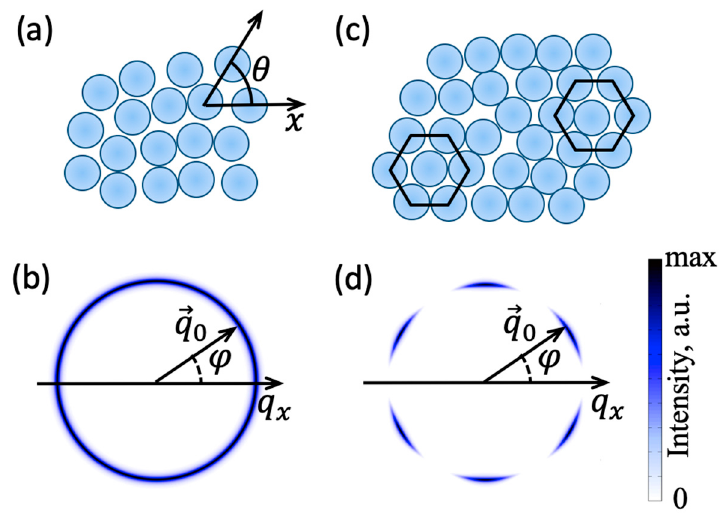
Figure 3. ( a ) Local BO order field Ψ n ( r ) in a 2D system with the short-range BO order; ( b ) Di ff raction pattern in the case of the short-range bond-orientational (BO) order; ( c ) schematic structure of the 2D hexatic phase exhibiting a quasi-long-range sixfold BO order; ( d ) di ff raction pattern from the 2D hexatic phase. Color in ( b , d ) represents the intensity of the scattered X-rays.